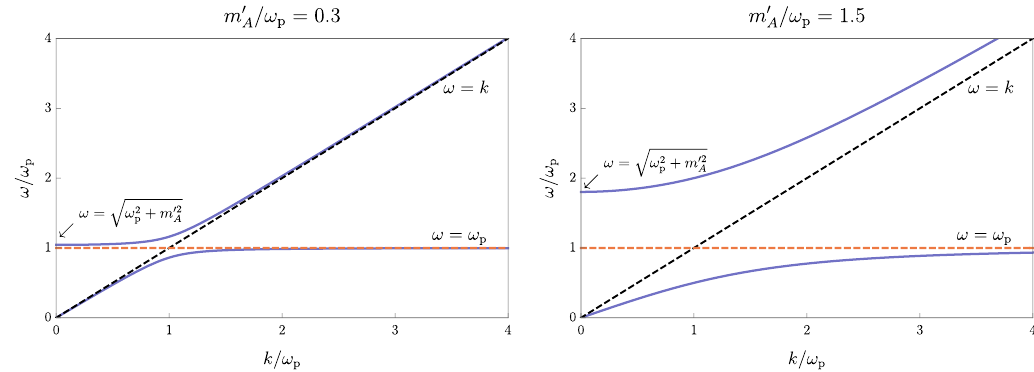
Figure 14. Plot of the two branches of the dispersion relation in a cold collisionless plasma for m A 0 = 0 . 3 ω p and m A 0 = 1 . 5 ω p , using eq. (C.4) with ν = 0 . The slow (lower) branch asymptotes to ω = ω p (dashed, orange) at large k , in both cases, whereas the fast (upper) branch asymptotes to the light cone ω = k (dashed, black). As m A 0 increases, the branches move further away from each other. For any m A 0 , the fast branch has ω = ( ω 2 p + m 2 ) 1 / 2 at k = 0 . A 0